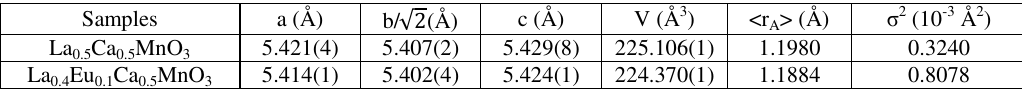
σ 2 values for La A > and 0.5-x Eu x Ca 0.5 MnO 3 (x=0 and 0.1) samples.